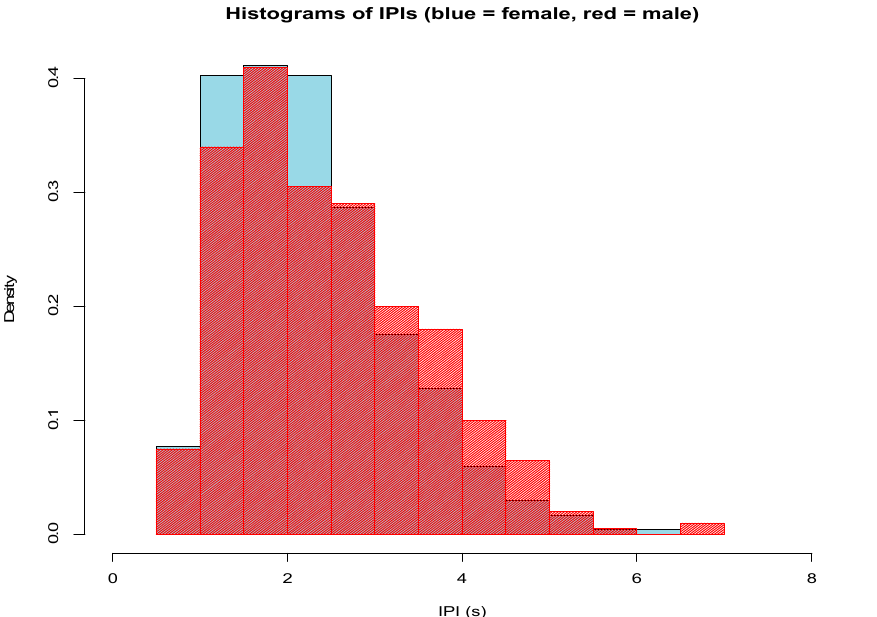
Figure 4. Superposed histograms for IPI (in seconds) for females (blue) and males (red), for the Brazilian participants in the Current Set.